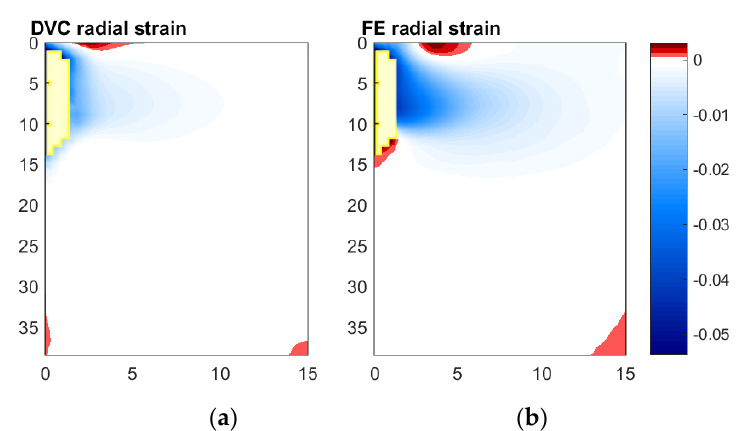
Figure 10. Comparison of radial strain fields measured and predicted, Digital Volume Correlation ( a ) and Finite Element ( b ), for Displacement Step 3 relative to reference scan. Measurements with correlation coefficients below 0.9 have been excluded from both fields, at spatial locations shown in yellow.